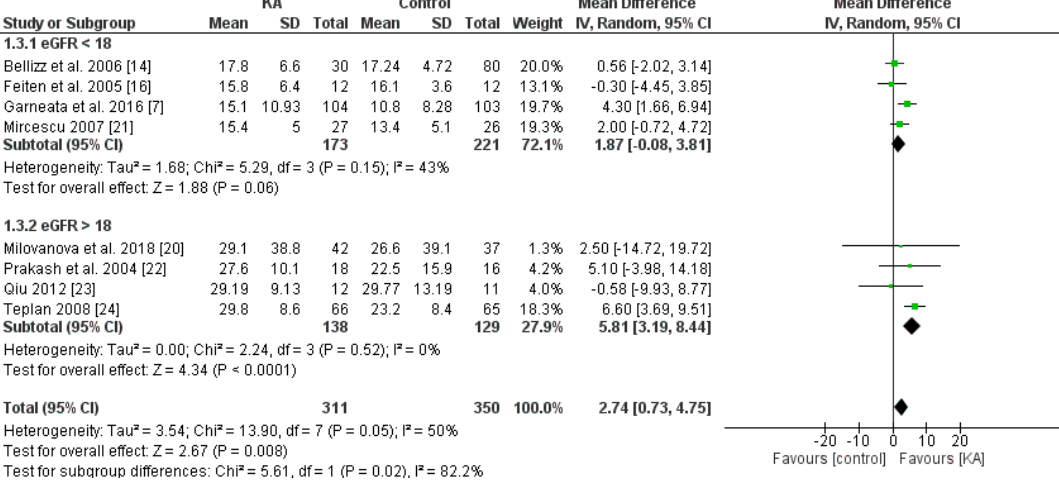
Figure 4. Forest plot of effects of KA on eGFR in CKD patients sub-grouped by eGFR. The random-effects model was utilized.